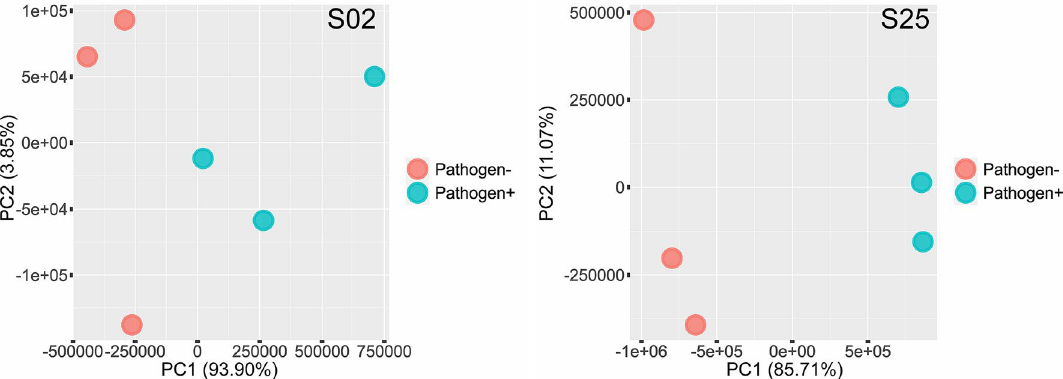
Figure 4. PCA plots of transcriptome profiles of Paenibacillus sp. strains S02 (left) and S25 (right) when grown in media with F. verticillioides (Pathogen+) and without F. verticillioides (Pathogen−) in the bacteria-pathogen interactions assay. Percentage variance explained by each axis are given in brackets. Distinctive clusters indicate that the presence/absence of F. verticillioides in the media changed the transcriptome profiles of strain S25 (along the PC1